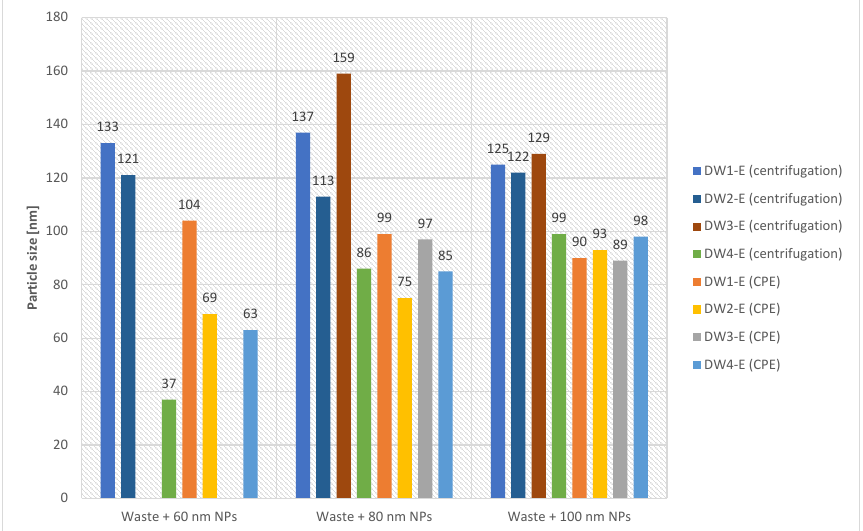
Figure 11. Particle size comparison of drilling waste samples enriched with AgNPs DW(1-4)-E of different sizes. Silver nanoparticles of three sizes, 60, 80, or 100 nm, were added to the samples. The graph shows the results obtained for particle size obtained after separation by CPE or centrifugation.